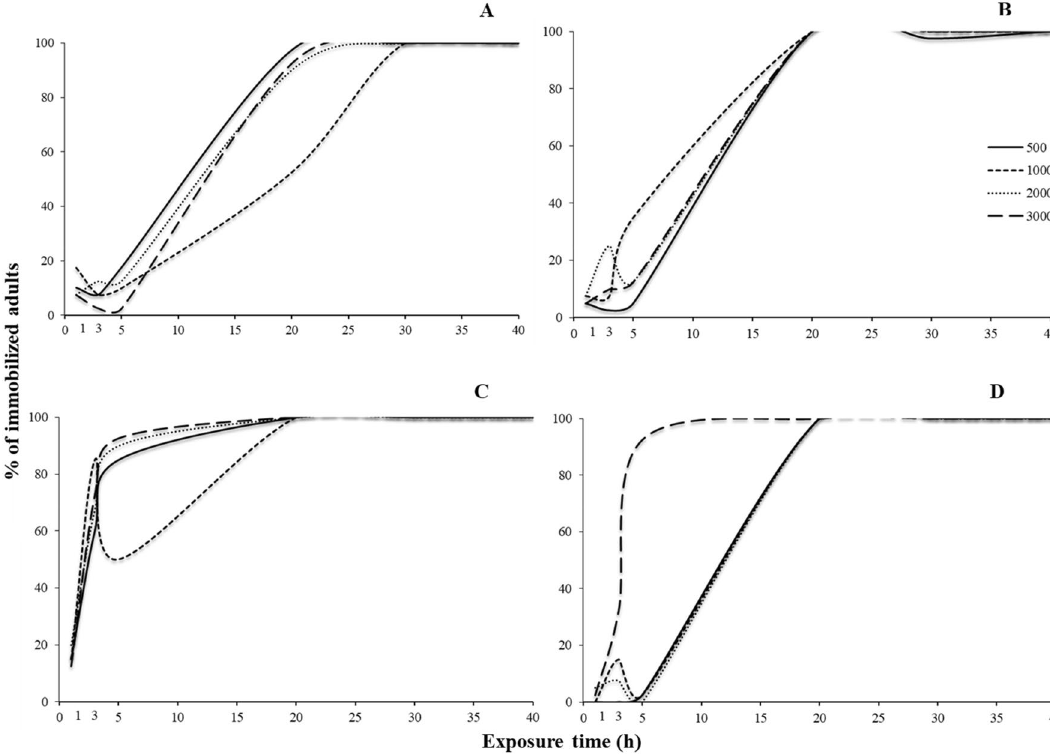
Figure 8. Percentage (%) of immobilized adults of resistant populations of stored product beetle species, for different exposure times (1, 3, 5, 20, 30 and 40 h) and different concentrations of phosphine, i.e. 500 ( A ), 1000 ( B ), 2000 ( C ) and 3000 ppm ( D ) after 7 days. The equations for each exposure interval for each species are presented in Table